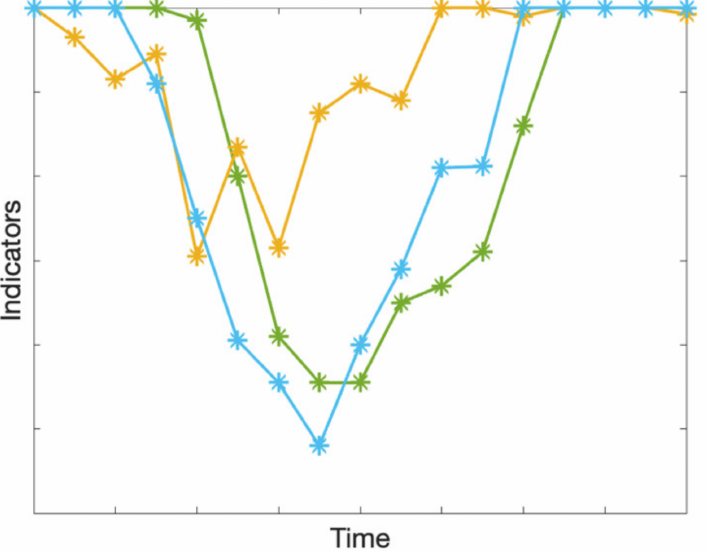
Figure 4. Schematic of the variation of line key indicators in the Beijing subway system over